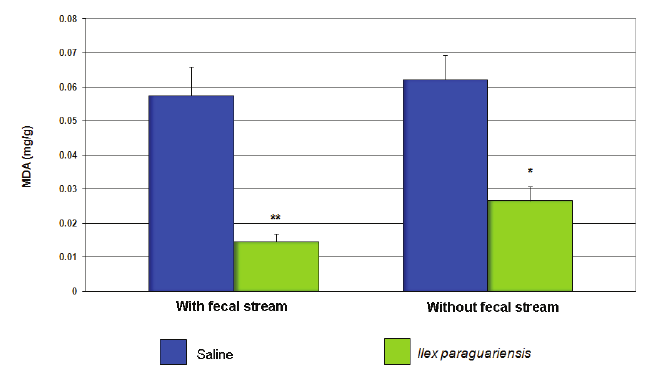
FIGURE 3 – Tissue levels of MDA in colon segments with and without fecal stream irrigated for two weeks with aqueous extract of Ilex paraguariensis or saline. **significant; p<0.05. Mann Whitney